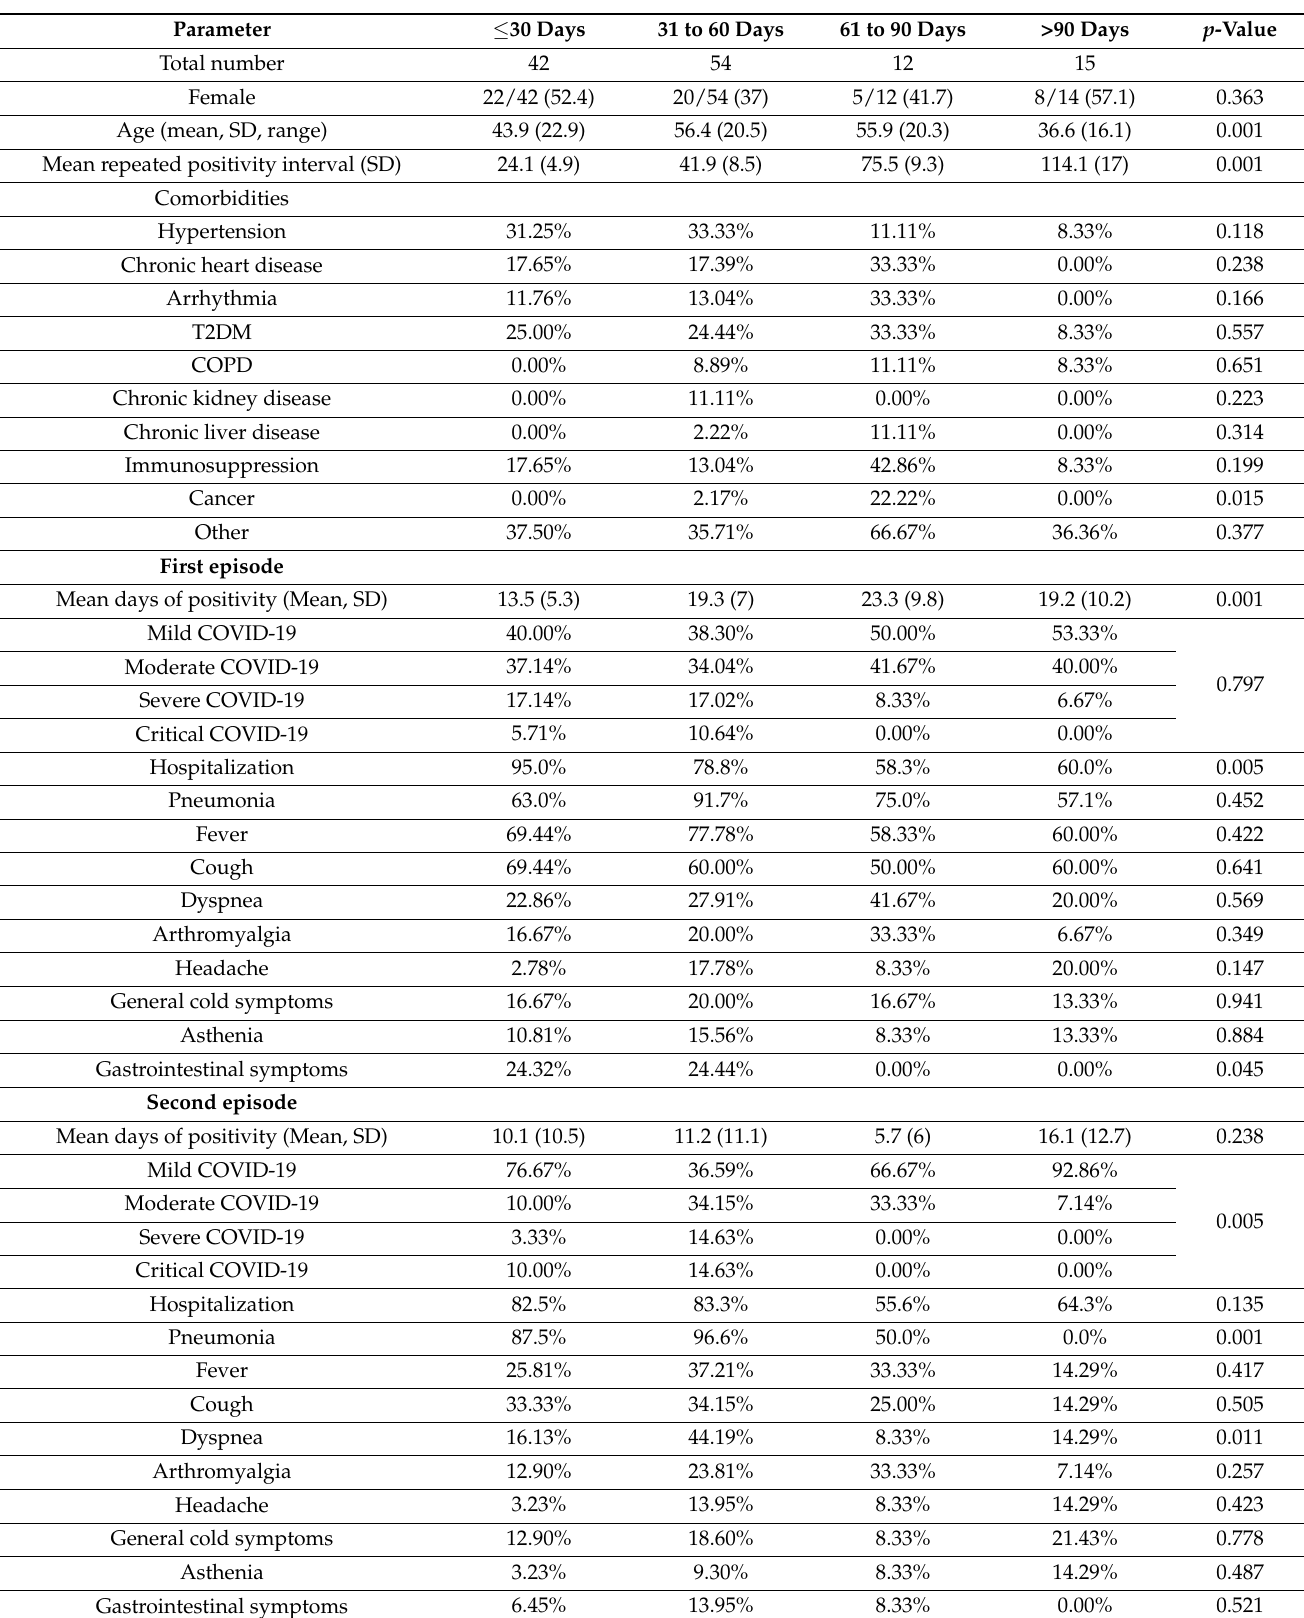
Table 3. Characteristics of the analyzed patients based on the repeated positivity